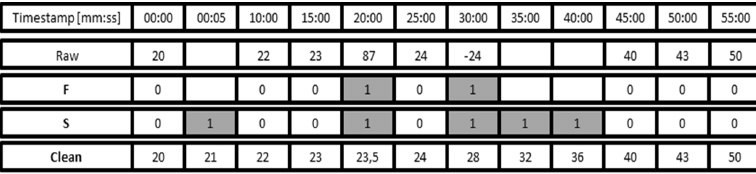
Figure 3. The Clean data row containing raw and synthetic data after the sanitation process.